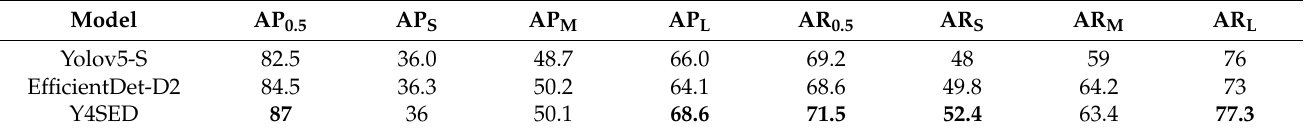
Table 8. Experimental results—Models were evaluated using Microsoft COCO standards.